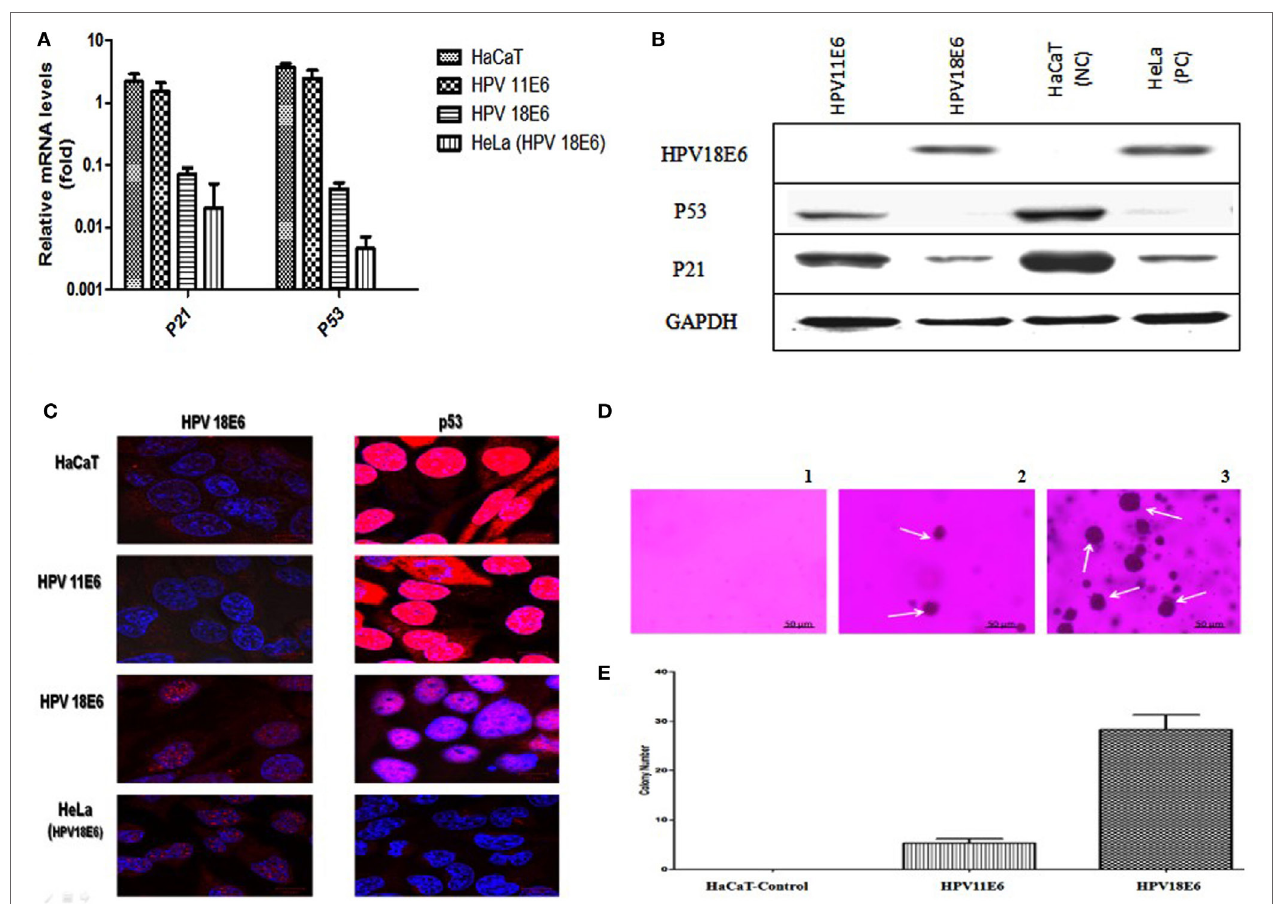
FigUre 2 | HPVE6 induces cellular transformation. (a) Quantitation of p21 and p53 mRNA in the adenovirus-HPVE6-infected cells as determined by qRT-PCR. A reduction in the mRNA levels of both genes in HPV18E6-infected HaCaT cells and the positive control (PC) HeLa cells was seen as opposed to the unchanged levels in the HPV11E6 infected cells. (B) Analysis of HPV18E6 (18 kDa), P21 (21 kDa), and P53 (53 kDa) protein levels by western blot analysis showed a marked reduction of both P53 and P21 in the HPV18E6 infected HaCaT cells but only a marginal decrease in the HPV11E6 cells. Uninfected HaCaT cells served as negative control (Nc) and HeLa cells are known to constitutively express the HPV18E6 protein served as PC. (c) The localization of HPV18E6 and P53 in HaCaT cells infected with HPV11E6 and HP18E6 was determined by confocal microscopy. In HPV11E6-expressing cells, p53 was localized primarily in the nucleus with some diffused staining in the cytoplasm, whereas in HPV18E6-expressing cells, p53 was observed at lower levels than either in the control or the HPV11E6 infected cells, with increased cytoplasmic staining. (D,e) Anchorage-independent cell growth as determined by colony formation in soft agar. Cells were plated at a density of 2.5 × 10 3 cells/well and colony formation determined after 21 days as described in the Section “Materials and Methods.” Analysis of the colonies was done using the ImageJ software (33), with colonies larger than 150 μm in diameter being scored as positive. Graph shows mean number of colonies (±SE) obtained in three independent experiments, with each experiment performed in six replicate